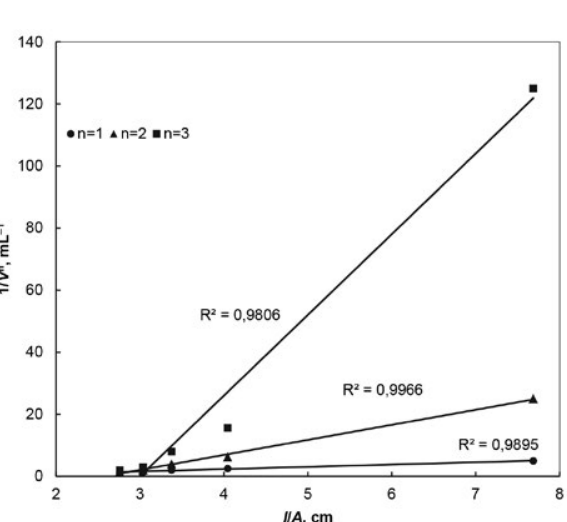
Figure 3. Determination of molar ratio ( n ) Mo(VI):3,5-DNC by the method of Asmus C = 2.08 × 10 ‒5 M; C Mo(VI)